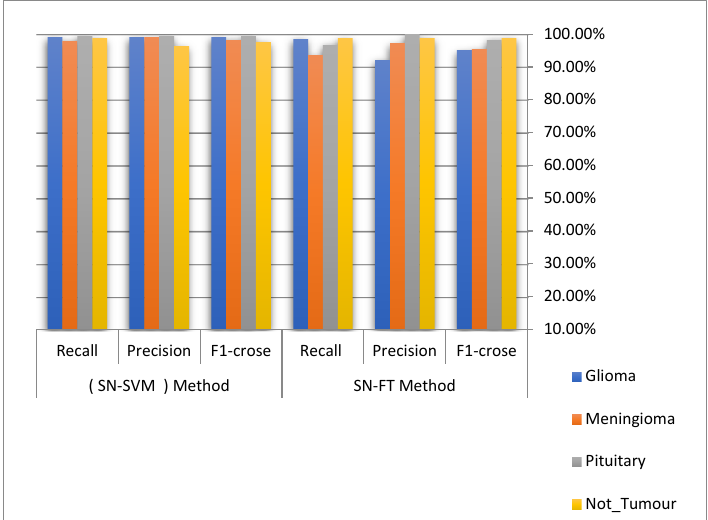
Figure 10. The results performance of the SN-SVM and SN-FT methods for classification types of tumours (glioma, meningioma, and pituitary tumour) and not-tumour.